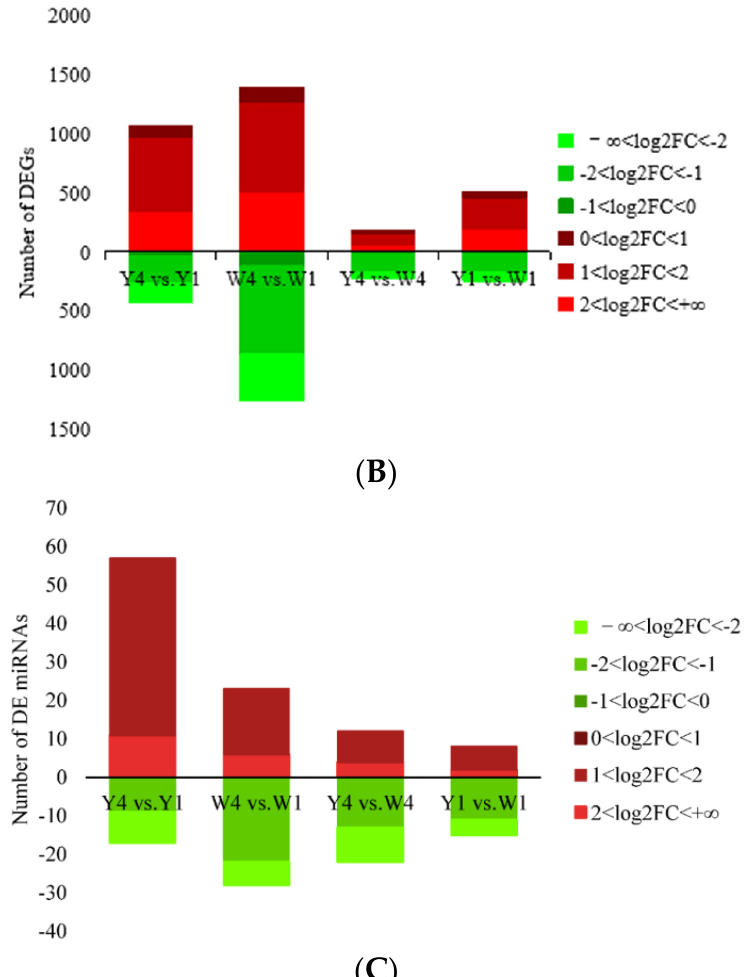
Figure 2. Number of differentially expressed lncRNAs, genes, and miRNAs in the TIC. Number of DE lncRNAs ( A ), DEGs ( B ), and DE miRNAs ( C ) for Y4 vs. Y1, W4 vs. W1, Y4 vs. W1, and Y1 vs. W1 comparisons, respectively. Up-regulated and down-regulated DEGs are represented in red color and green color, respectively. The different ranges of Log2FC are shown by the different color shades. In the Yorkshire pigs, 1478 DEGs were identified, among which 1051 genes